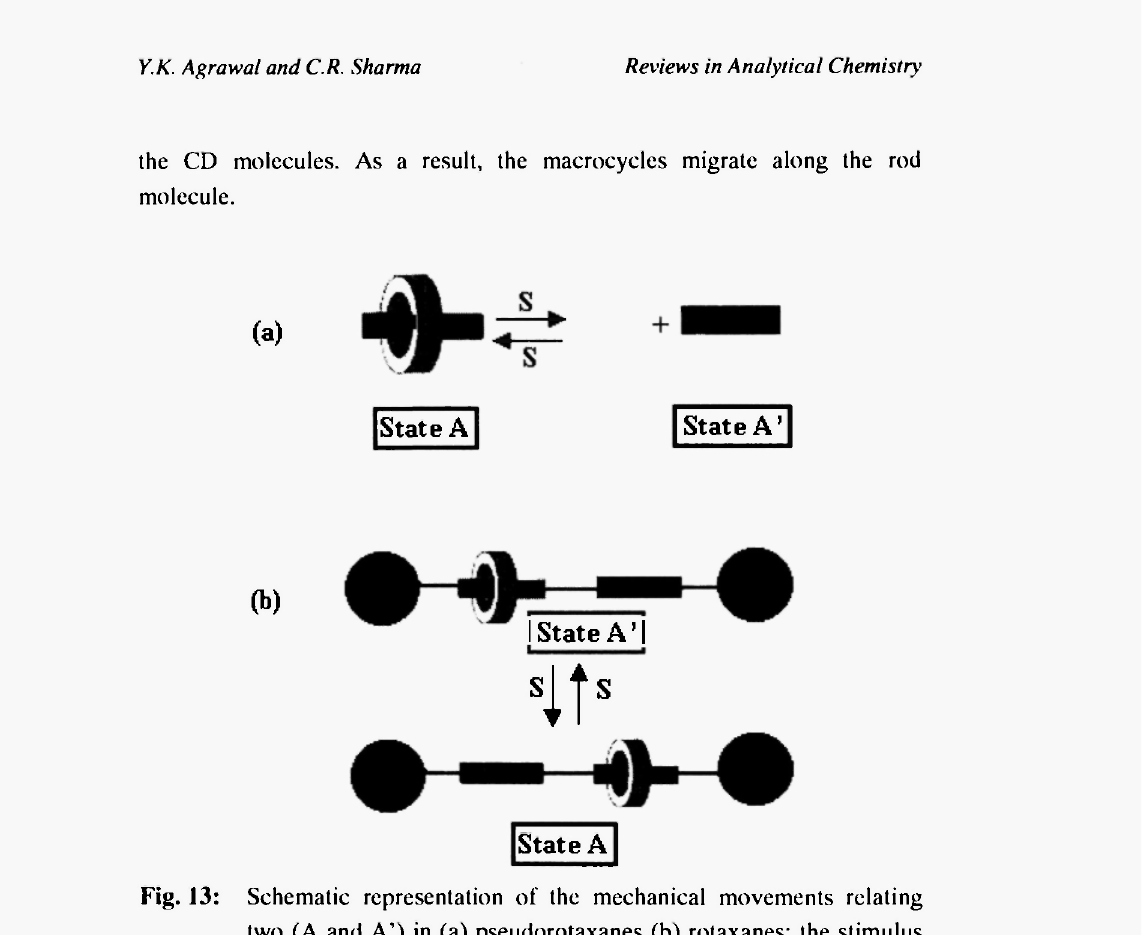
Fig. 13: Schematic representation of the mechanical movements relating two (A and A') in (a) pseudorotaxanes (b) rotaxanes: the stimulus (S) can be chemical or electrochemical energy, or it can be